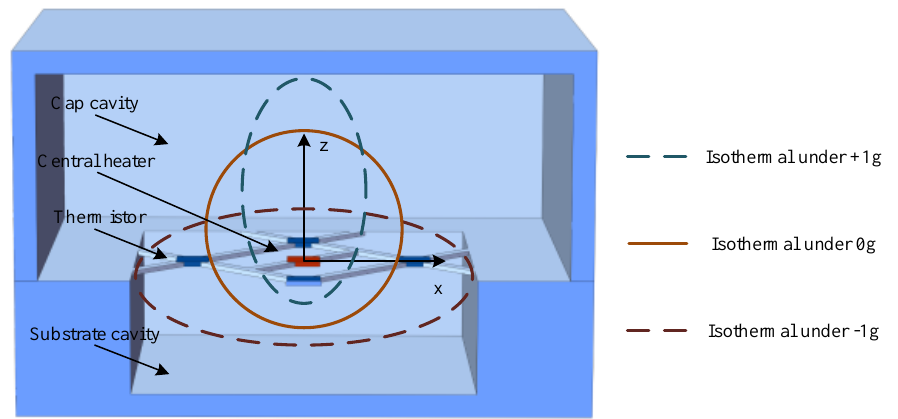
Figure 6. Structure and isothermals under different Z -axis accelerations of the planar tri-axis thermal convective accelerometer.